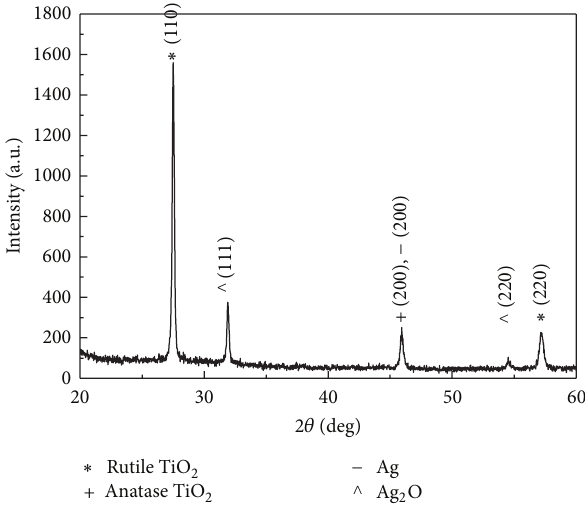
Figure2:GlancingangleX-raydiffractionpatternofAg:TiO 2 nano- compositethinfilmannealedat400 ∘ C.(Differentphasesareindexed as different symbols: ∗ for rutile TiO 2 , + for anatase TiO 2 , − for Ag, and ∧ for Ag 2